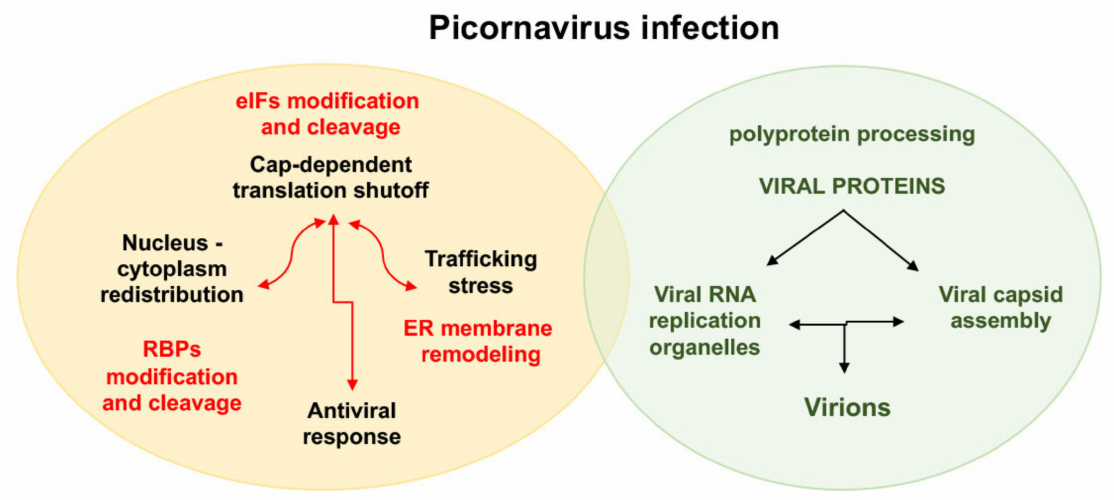
Figure 2. Schematic representation of main events in picornavirus infected cells. Following attachment of the virus to the receptor on the cell surface, internalization, and uncoating leads to release of the viral RNA into the cytoplasm of the host cell. The virus life cycle then proceeds to translation of the polyprotein precursor encoded in the viral genome through interaction with the host translation machinery (green oval). Processing of the polyprotein by viral encoded proteases renders the mature viral proteins required for virus multiplication. Viral RNA replication takes place in viral RNA replication organelles within reorganized cell membranes. Following assembly of viral capsids, the viral RNA is packaged into virions. Viral infection also alters host gene expression through activation of signaling pathways, and modification and/or proteolysis of host factors (eukaryotic initiation factors (eIFs) and RBPs) by viral proteases, inducing cap-dependent shutoff, nucleus-cytoplasm redistribution, trafficking stress, and antiviral response (yellow